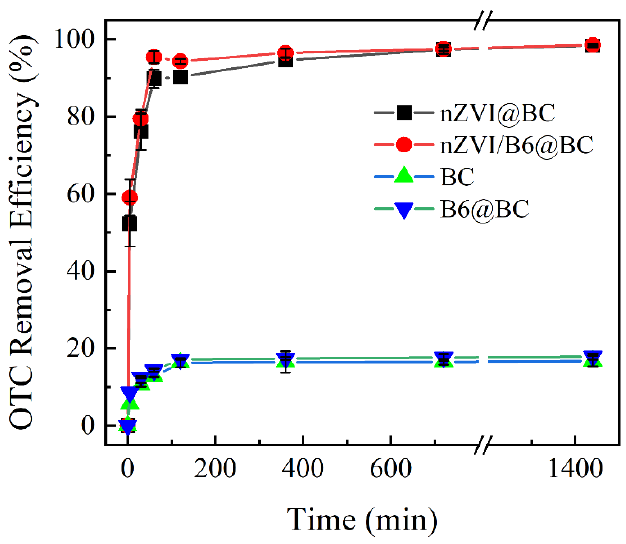
Figure 5. OTC removal performance of biochar materials at 25 °C, pH = 3.5.